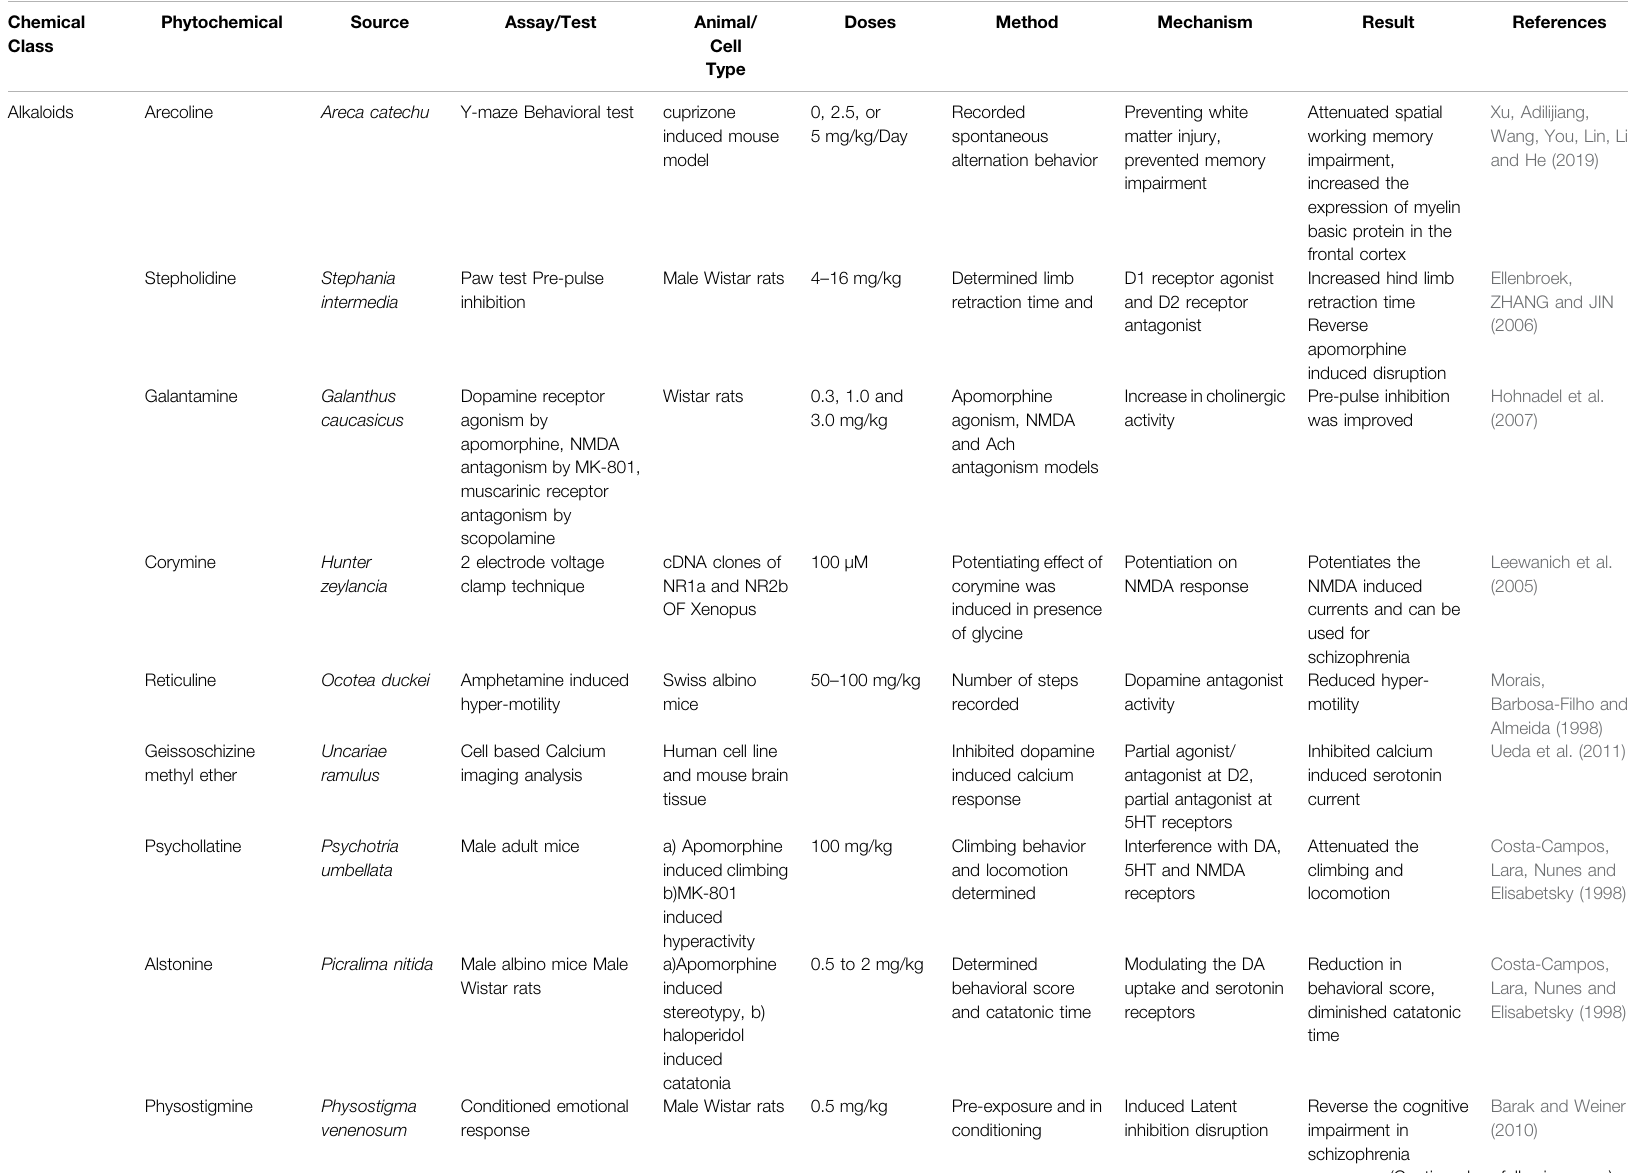
TABLE 1 | Antipsychotic potential of phytochemicals in non-clinical